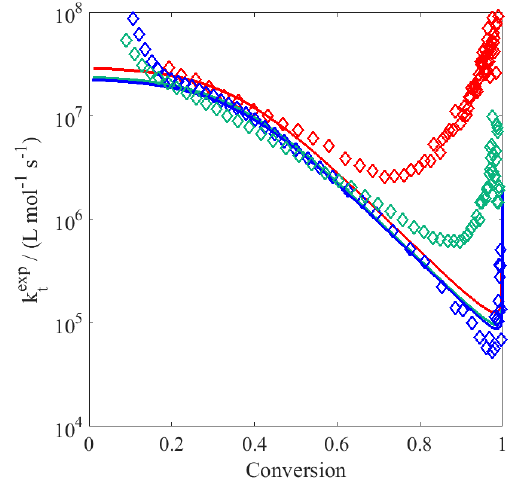
Figure 2. Termination rate coefficient as a function of the monomer conversion calculated from the propagation rate coefficient reported in Table 3 and the experimental data of conversion versus time of non ‐ ionized MAA polymerization (diamonds) at an initial monomer concentration equal to 1 wt % (red), 5 wt % (green), and 10 wt % (blue): comparison with the simulated k t using the model equations (lines).